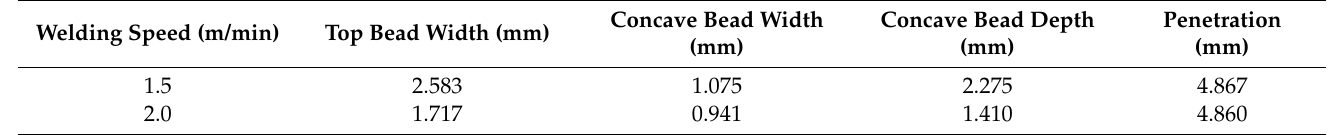
Table 3. Key bead dimension per welding speed.